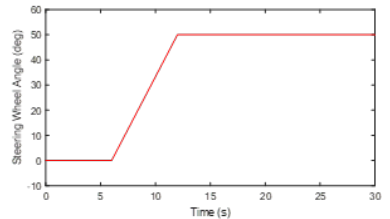
Figure 15. Small steering wheel angle.